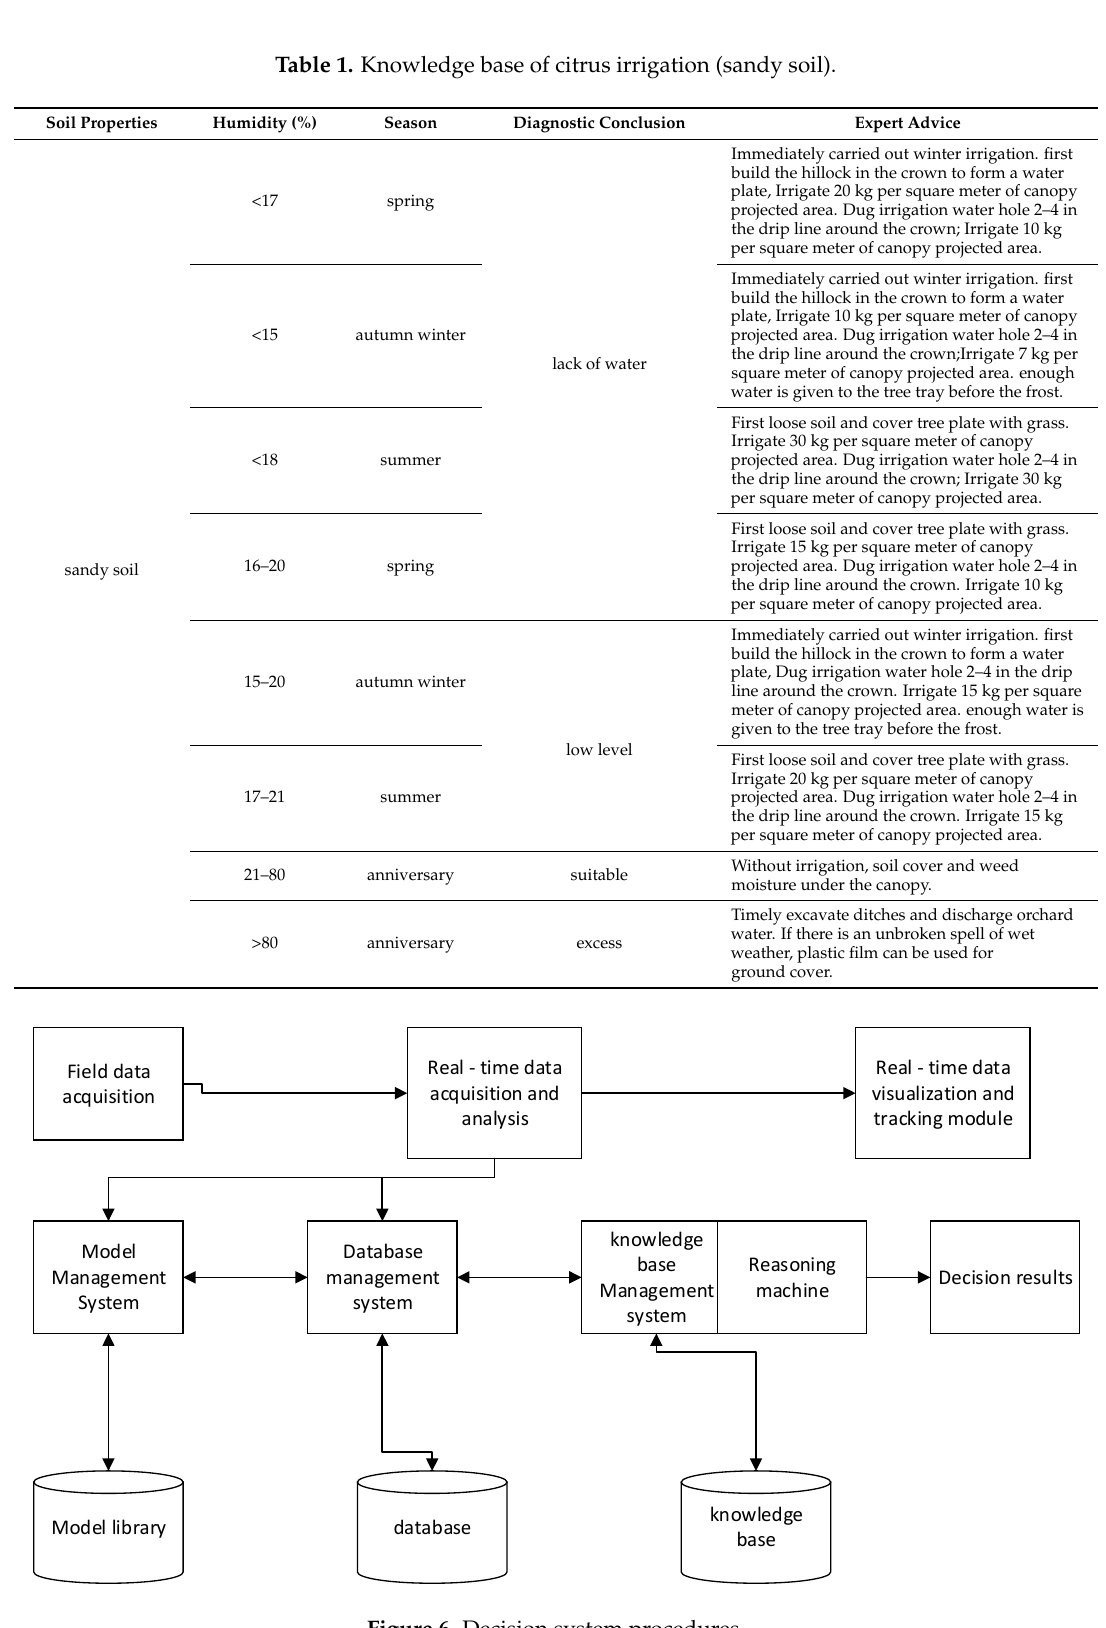
Figure 6. Decision system procedures.